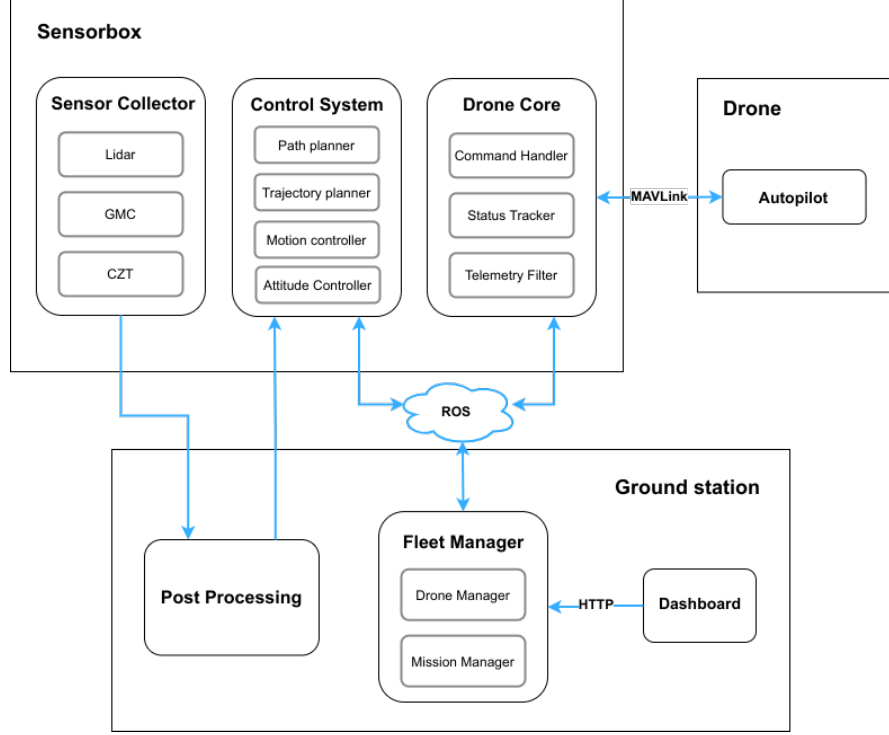
Figure 9. SW architecture of the Groundstation, Sensorbox and